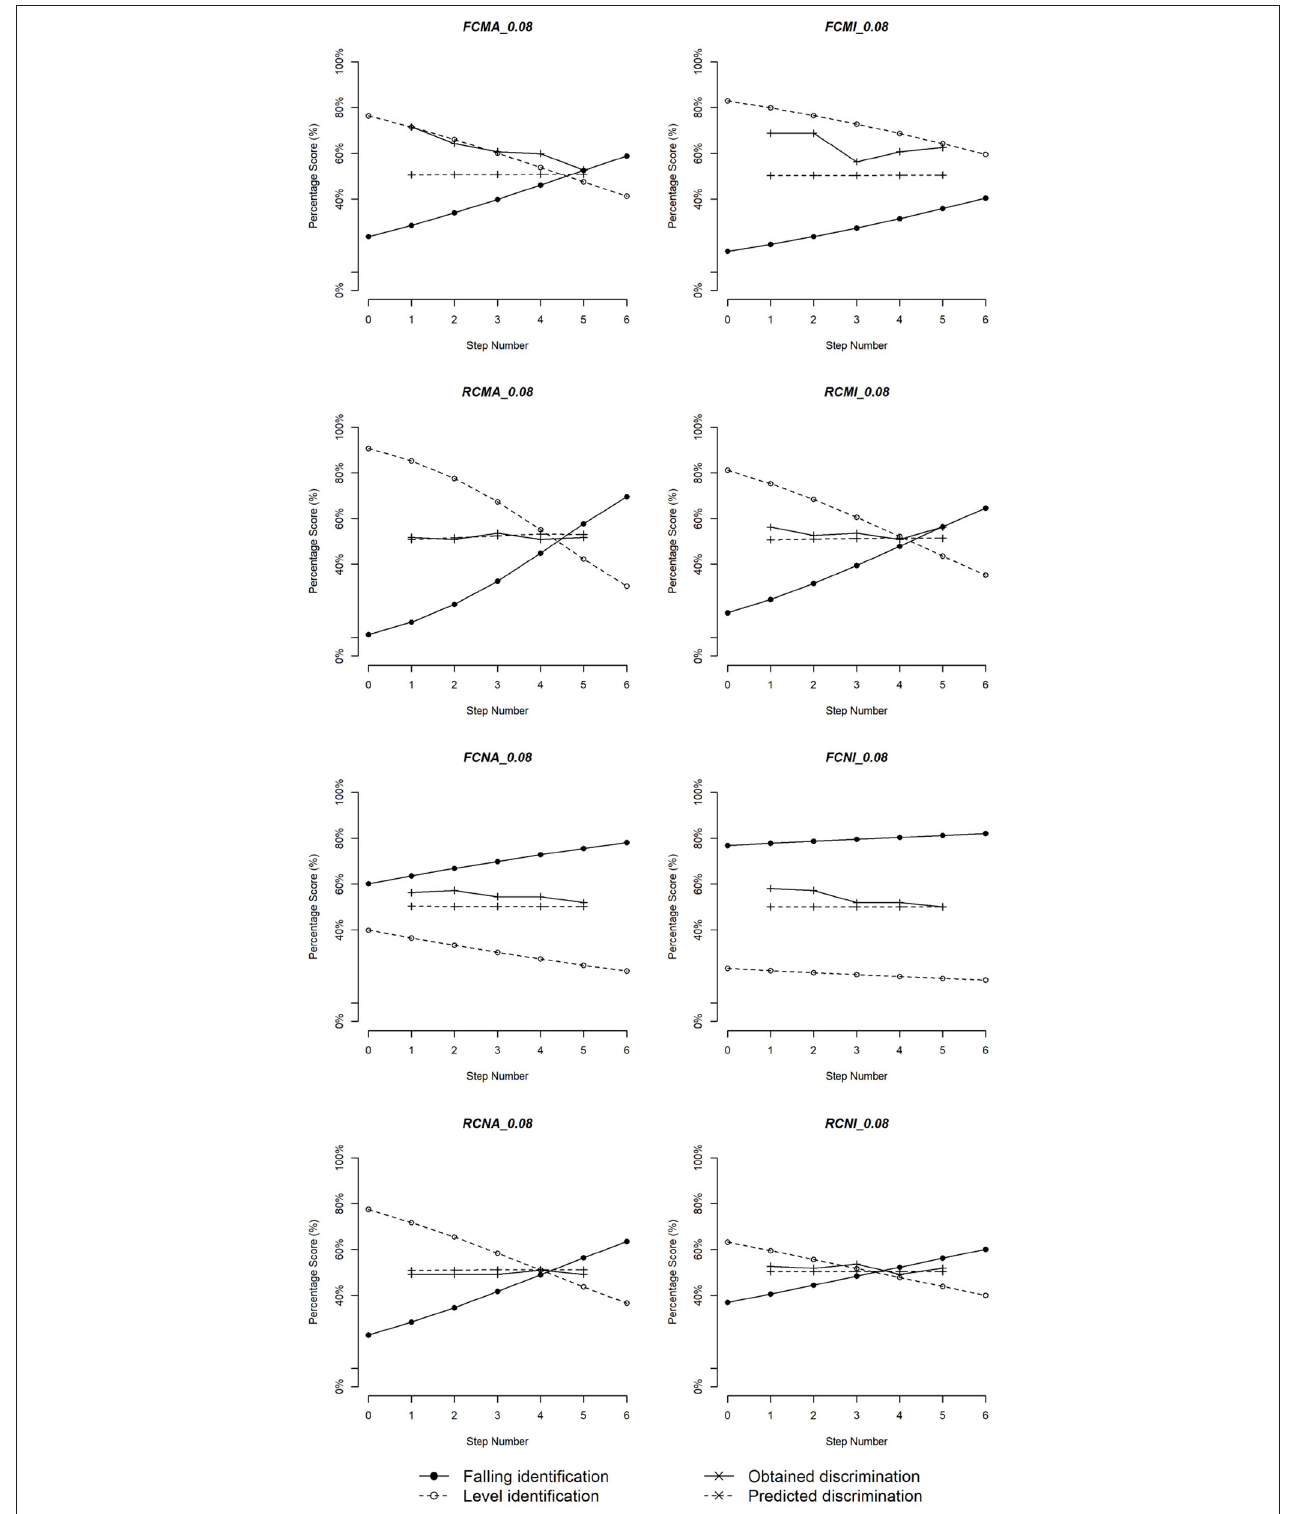
FIGURE 8 | Logistic identification functions and discrimination curves for eight subgroups of Cantonese speakers with duration 80ms.